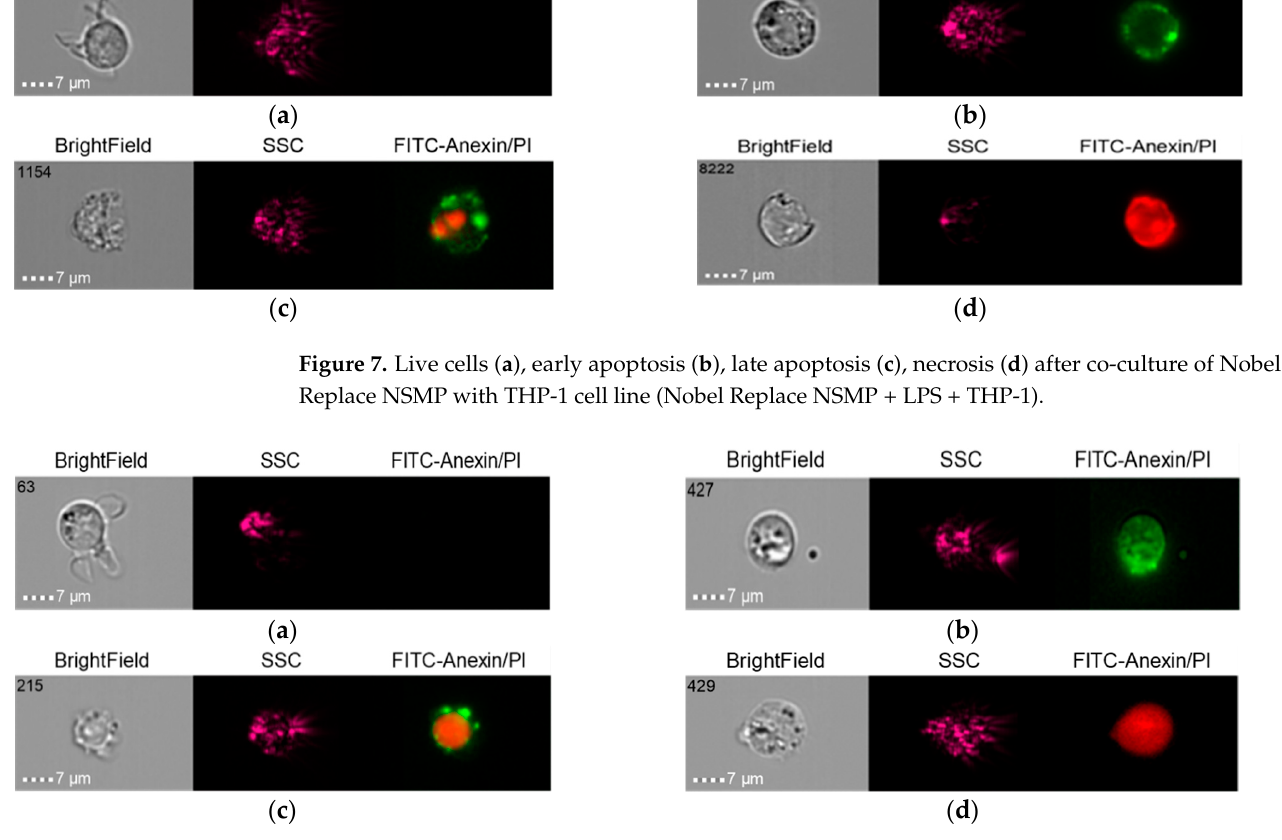
Figure 8. Live cells ( a ), early apoptosis ( b ), late apoptosis ( c ), necrosis ( d ) after co-culture of Nobel Replace NSMP with THP-1 cell line (Nobel Replace NSMP + DSP + LPS +THP-1).